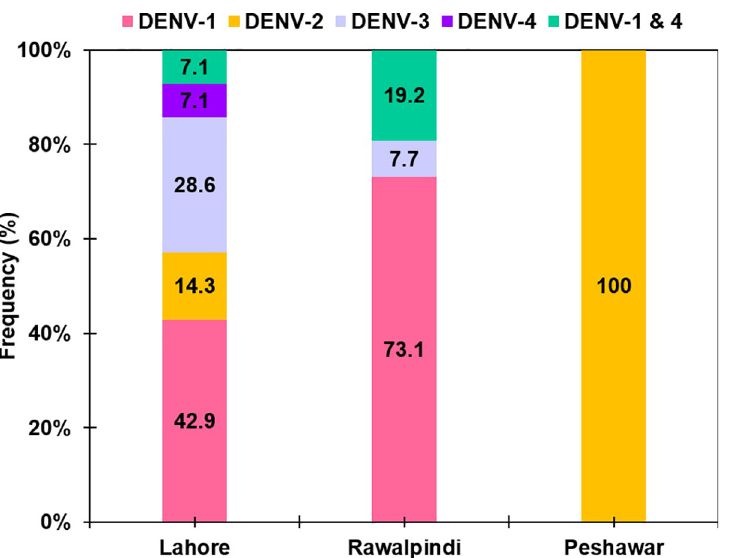
Fig 2. Prevalence of dengue virus serotypes circulating in different districts of Punjab and Khyber Pakhtunkhwa provinces of Pakistan in 2016–18. Among a total of 510 NS1 positive samples from dengue patients, 155 (30.4%) were PCR positive including 14 from Lahore, 26 from Rawalpindi, and 115 from